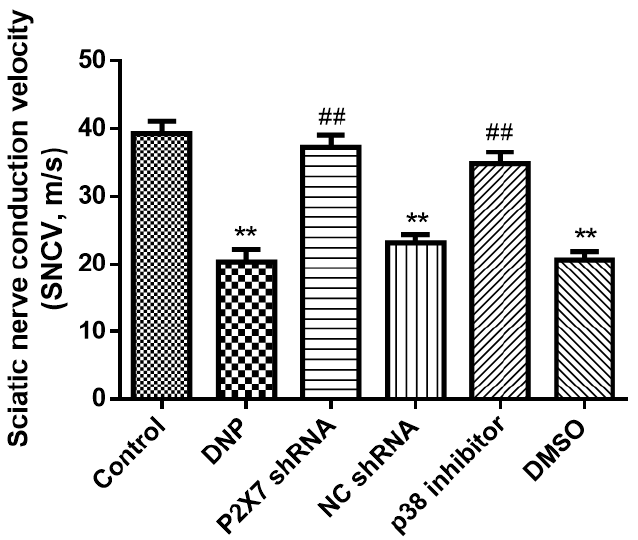
Figure 2. Sciatic nerve conduction velocity. The nerve conduction velocity of the DNP group was significantly lower than that of normal rats; however, there were no differences among the DNP, P2X7 shRNA, and NC groups. Intrathecal injection of P2X7 shRNA and p38 inhibitors decreased the rate of nerve injury. Data are shown as mean ± SEM based on at least three independent experiments, n = 6; ** p < 0.01 versus the Control group; ## p < 0.01 versus the DNP